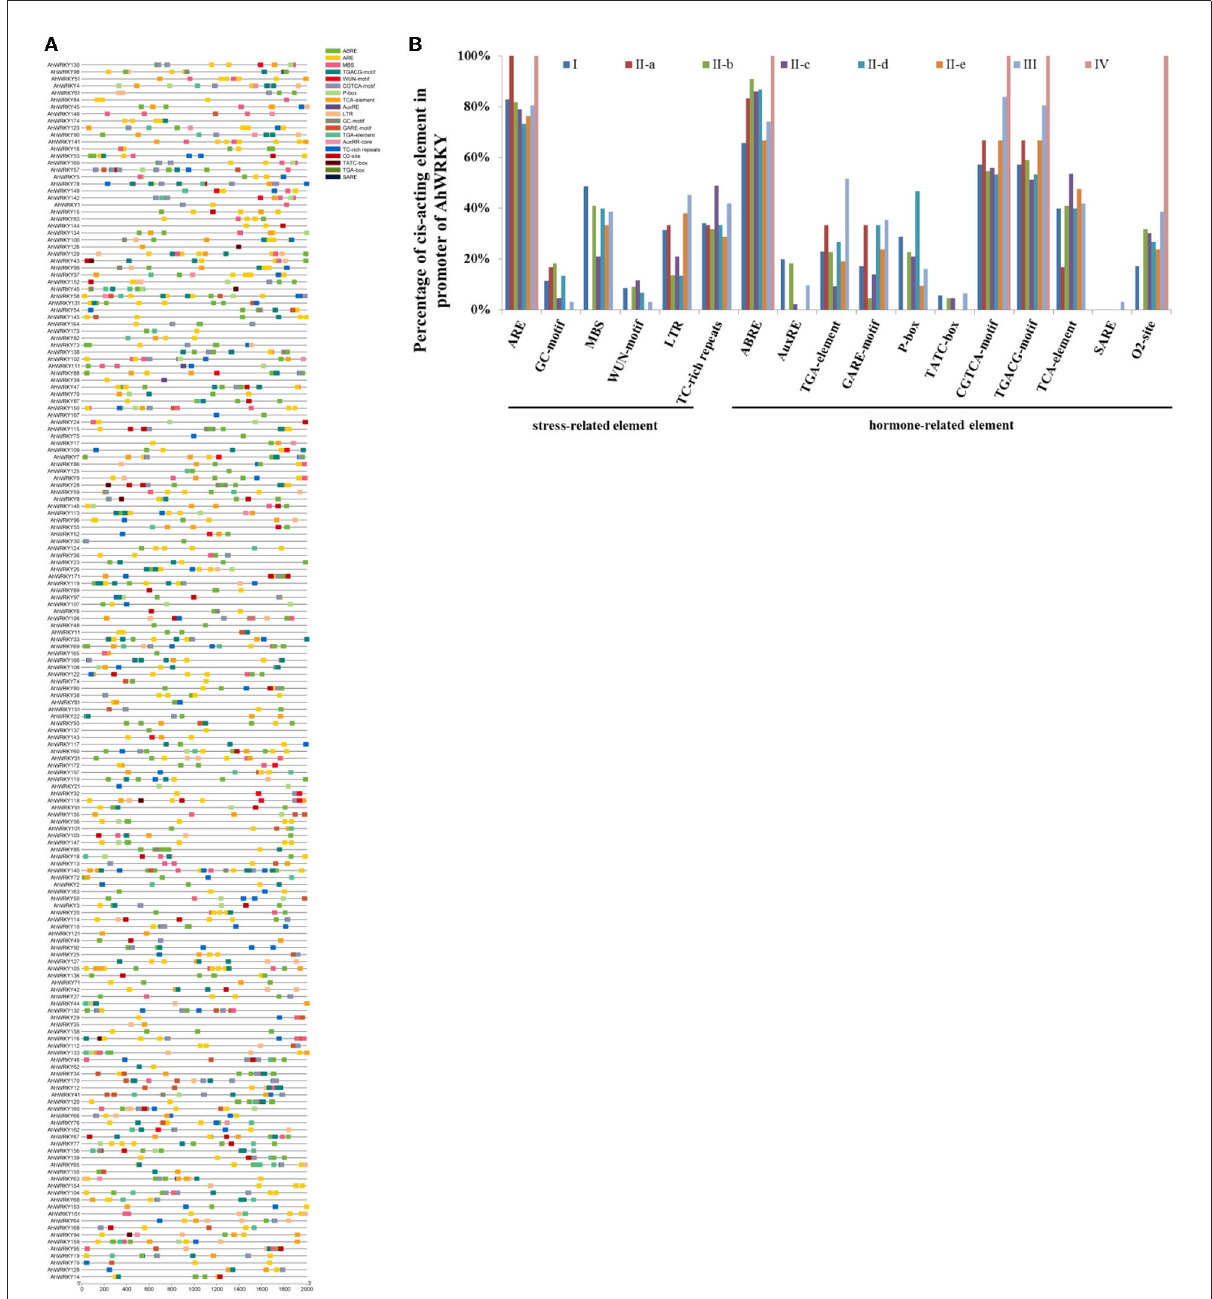
FIGURE5 Identification of the cis-acting element in the promoter of AhWRKY genes. (A) Each type of element is represented by a number of colored rectangles. Box length corresponds to element length. Different colors represent different group members. (B) Percentage of each cis-acting element in the promoter of the